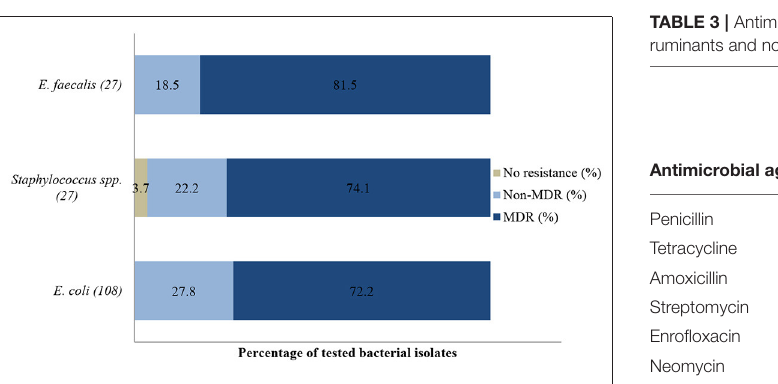
FIGURE 9 | Multidrug resistance of clinically important bacterial pathogens from diseased non-ruminants between 2015 and 2017. Numbers inside brackets “()” indicate number of isolates detected; those on bars indicate percentage per organism; MDR–multi-drug resistant. Non-MDR-Only resistant to 1 or 2 classes.